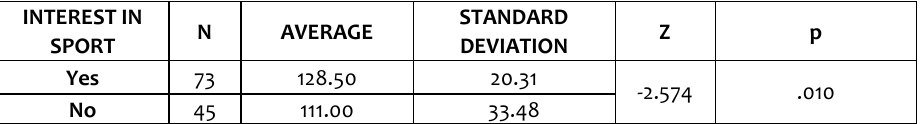
Table 6. Standard Deviation, Average and Socialization Levels of the Obese Participants in the Study According to their Interest in Sports INTEREST